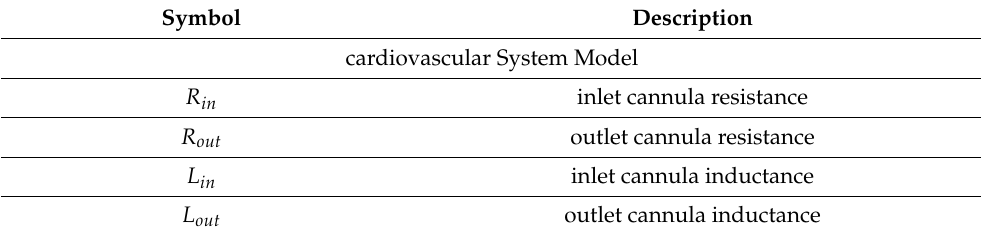
Table A1. Nomenclature of the CVS, estimator, and